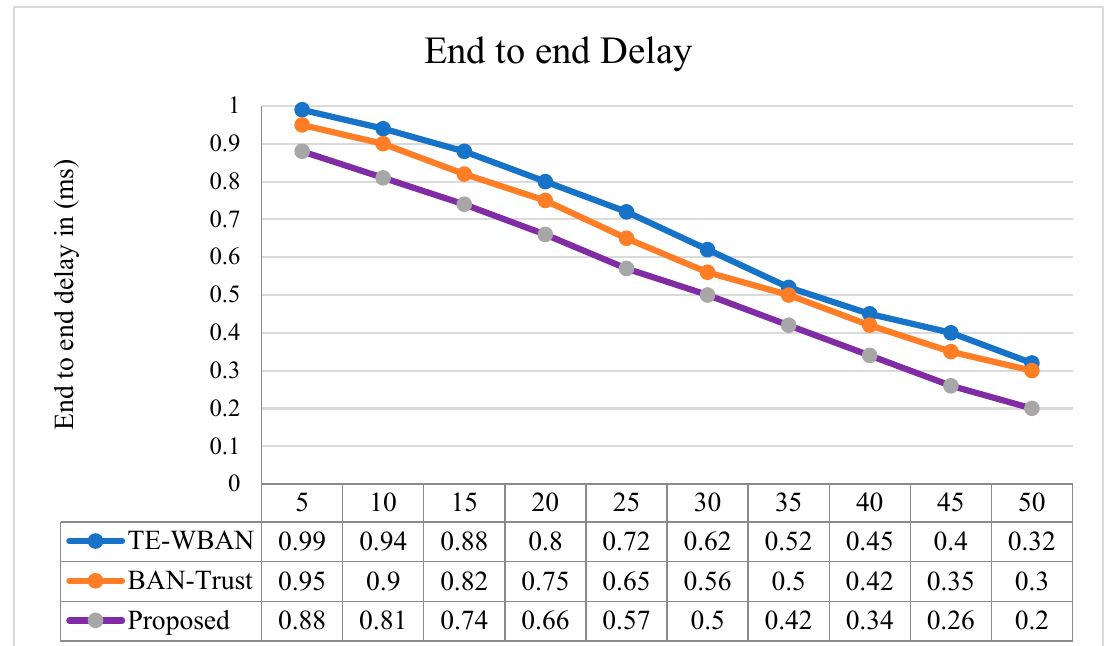
Figure 3. End-to-end delay vs. Percentage of malicious nodes.